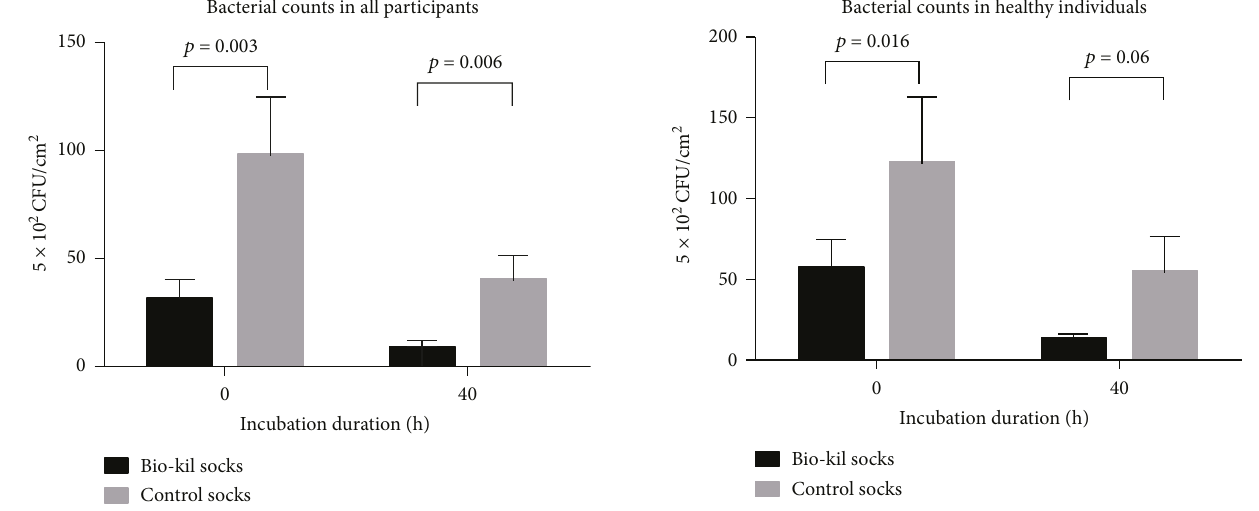
Figure 1: Bacterial counts in Bio-Kil-treated socks and control socks in all participants.